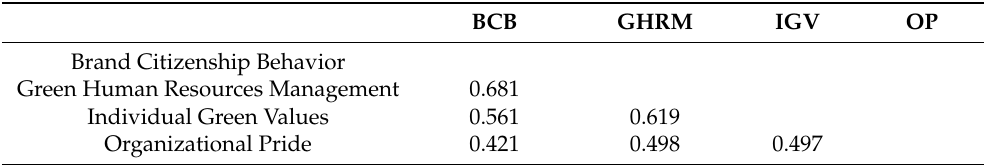
Table 4. HTMT Matrix.